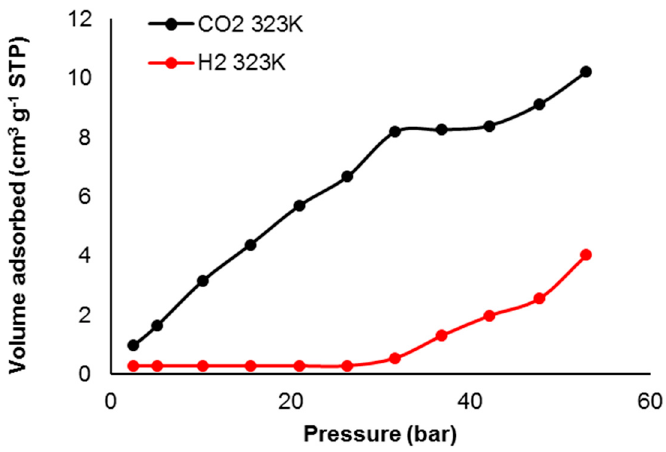
Figure 6. Adsorption isotherms of CO 2 and H 2 for polymer 4 .